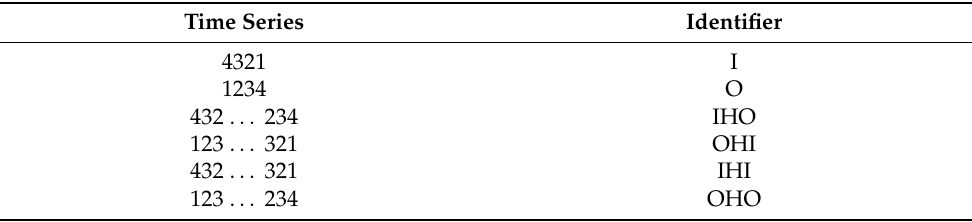
Table 4. Matching between time series and events. The ellipsis represents any series of values between 1 and 3 (for IHO and IHI) or between 2 and 4 (for OHI and OHO).